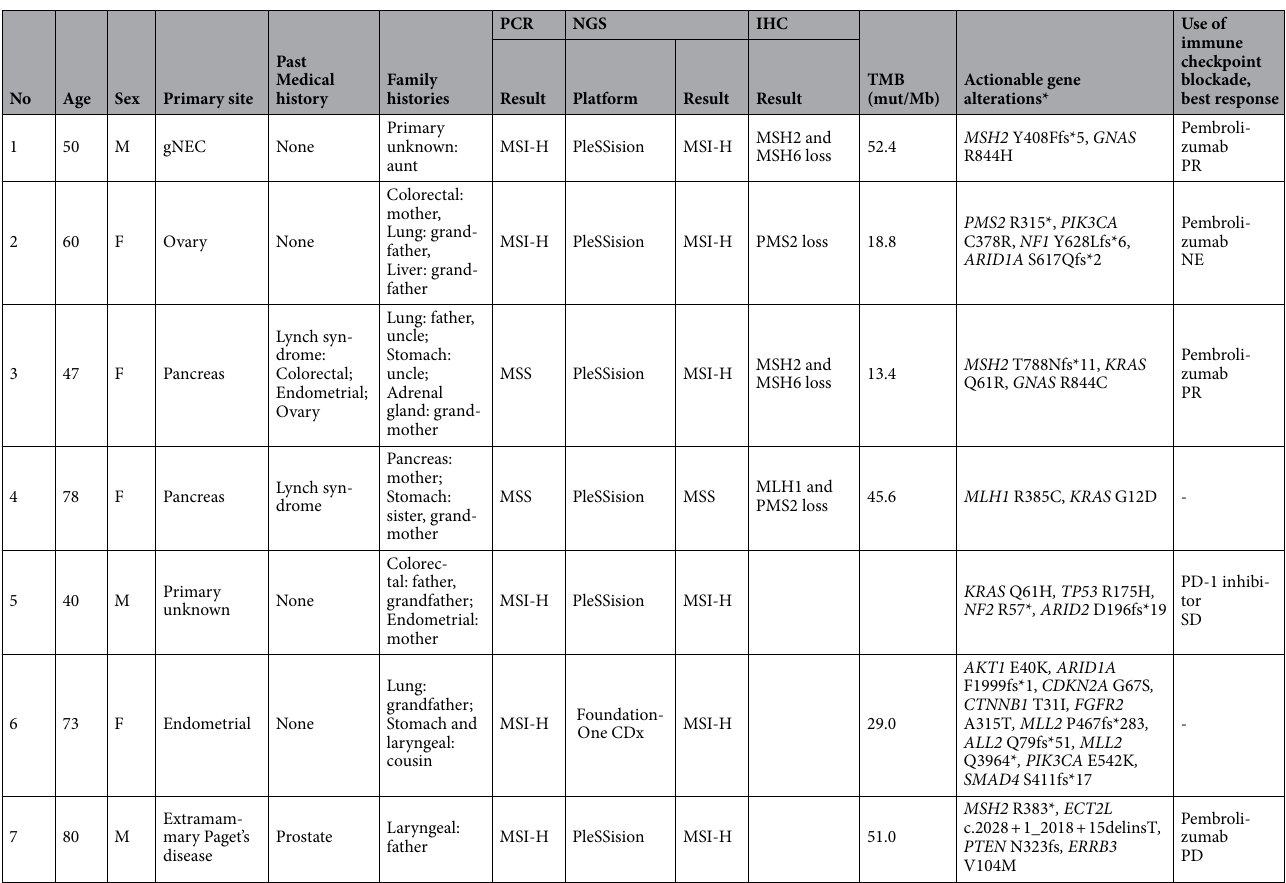
Table 2. Details for the seven cases with deficient mismatch repair (dMMR) and/or high microsatellite instability (MSI-H) confirmed by polymerase chain reaction-based testing and/or next-generation